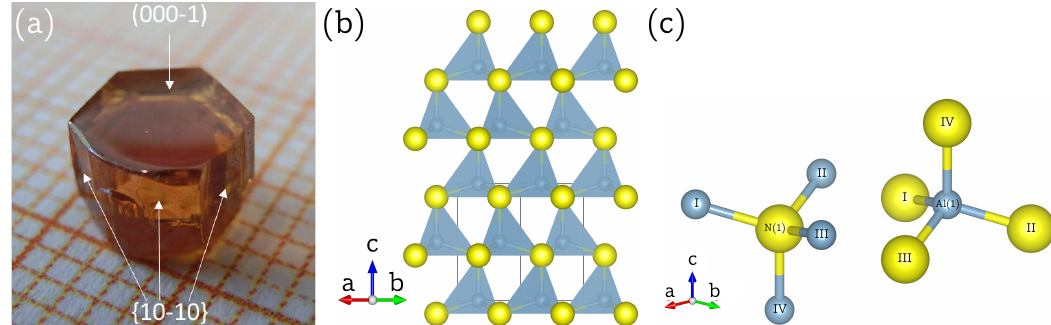
Figure 1. (a) Single crystal of aluminum nitride, AlN, from Leibniz Institute for Crystal Growth (IKZ, Berlin), with the crystallographic c axis and ab plane indicated by arrows.[10] (b) Wurtzite structure of AlN, according to Reference[9], viewed down the crystallographic (11-20) direction. The aluminum atoms (grey) and the nitrogen atoms (yellow), both located at Wyckoff position 2 b , are tetrahedrally coordinated by each other with one Al-N bond directed parallel to the crystallographic c axis. (c) Individual, tetrahedrally coordinated, aluminum and nitrogen atom in the crystal structure of AlN, in which the three equal, shorter, bonds Al/N—I/II/III [1.8891(8)Å] and the longer bond Al/N—IV [1.9029(16)Å] along the three-fold rotation axis are highlighted. a Drawing generated with the Vesta program [11].